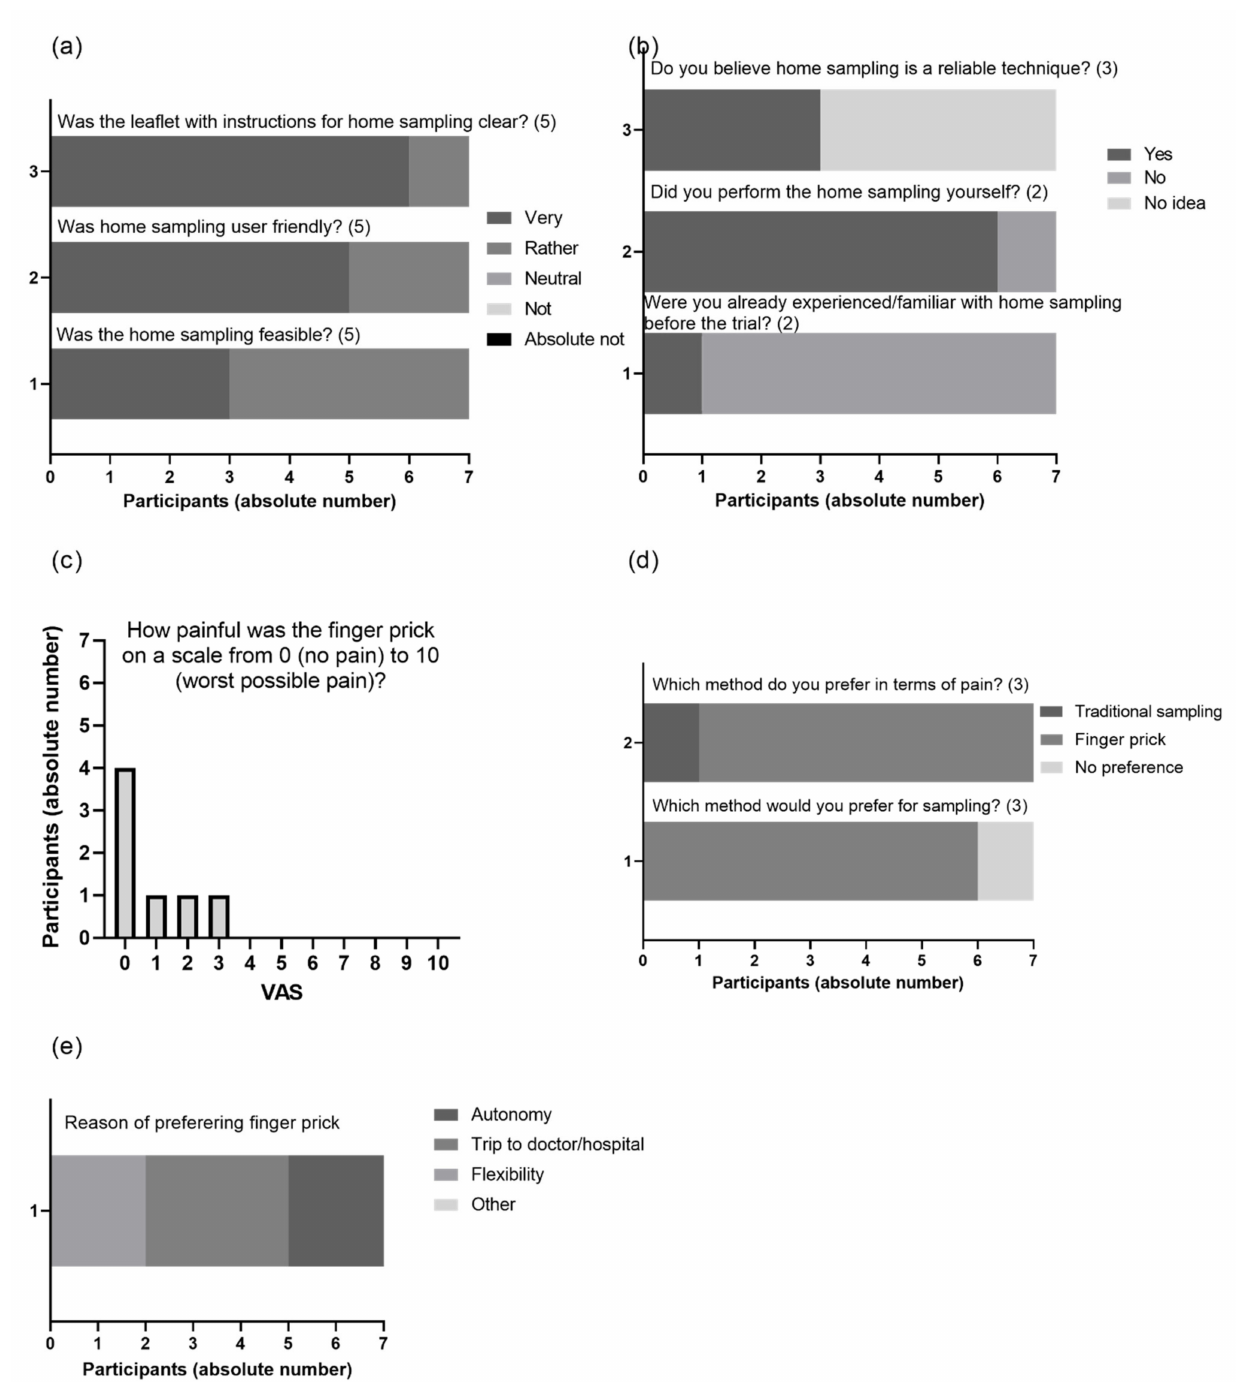
Figure 7. Microsampling was found to be easily executed by patients and preferred over venous sampling. After completing the substudy for microsampling, participants were sent an electronic survey to inquire into their experience. Patients scored questions on execution ( a ) and execution experience ( b ). Pain was quantified ( c , d ) and compared to traditional sampling ( d , e ). n = 7 The number between brackets in panel ( a , b , d ) indicates the number of possible